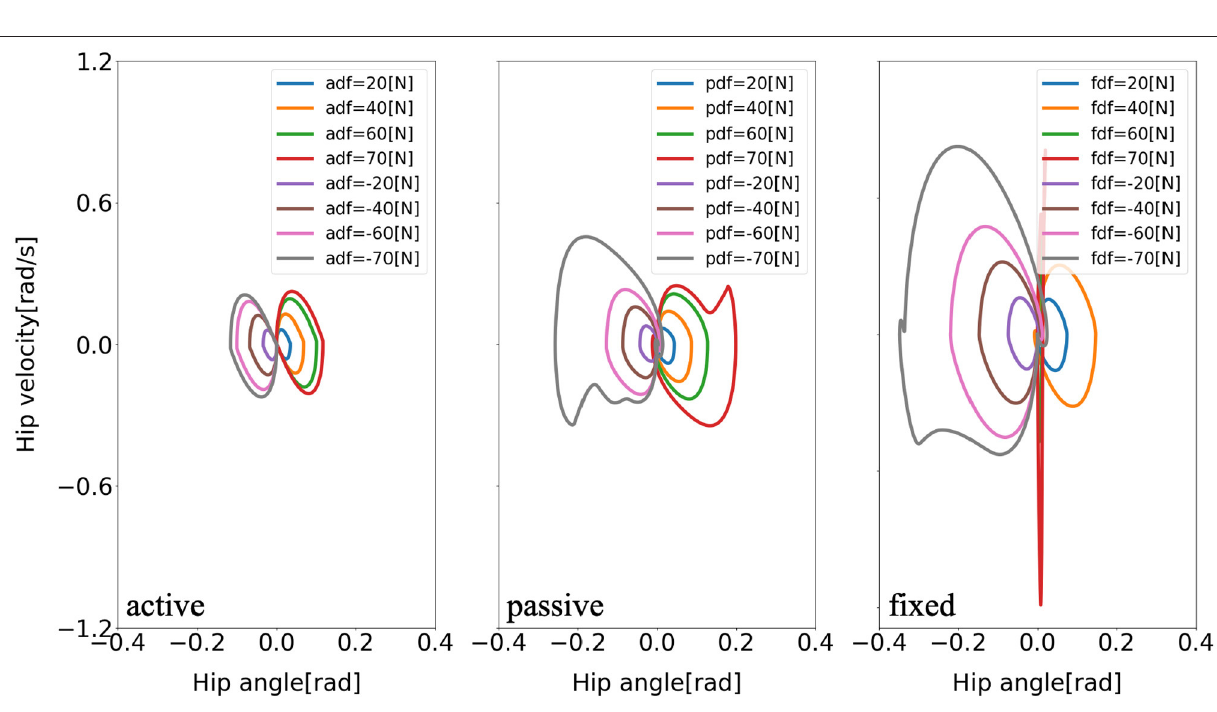
Frontiers in Neurorobotics | www.frontiersin.org